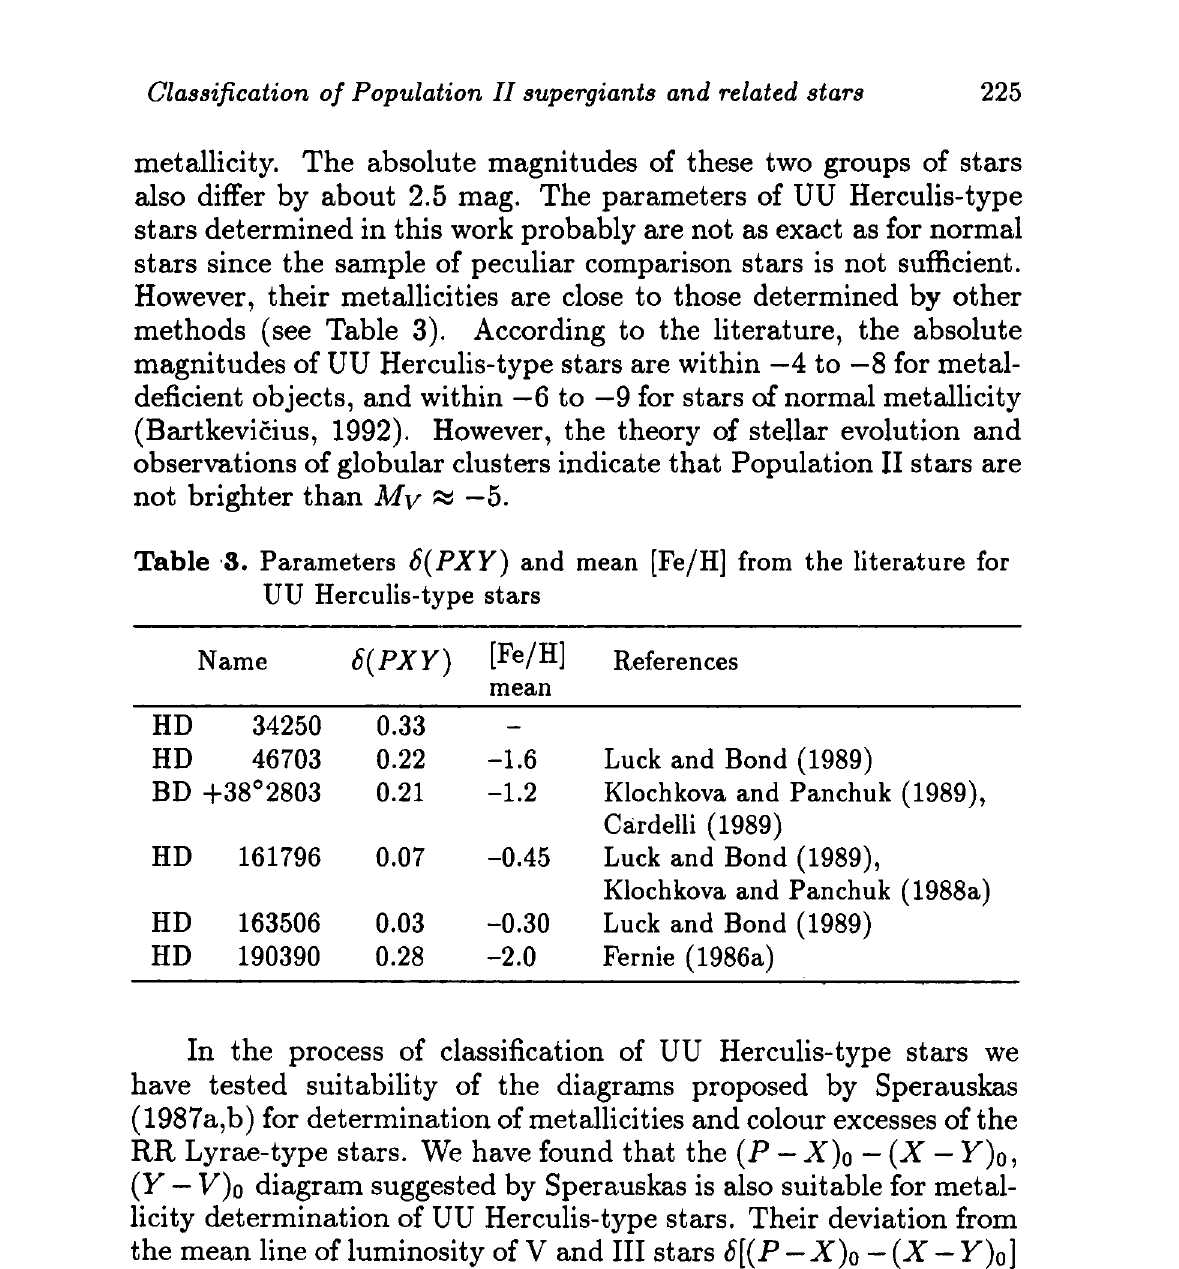
Table 3. Parameters S(PXY) and mean [Fe/H] from the literature for UU Herculis-type